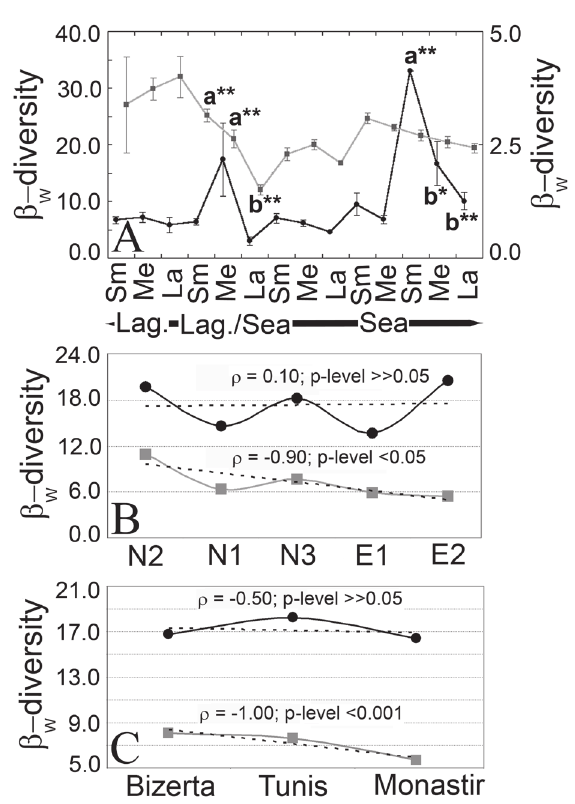
Fig . 5. – Line-plot of turnover of motile- and sessile-associated species at three increasing spatial scales. Sites and localities are primarily arranged according to lagoon-sea environmental gradient and secondarily to according to the north-east geographic gradient. A, beta-diversity at the small-scale level between the total richness of the investigated area and richness of Pinna individuals; means (±Se) are scaled separately for sessile (right) and motile (left) epi- fauna. AnoVA and tukey’s hSd test highlighted differences of means (letters on the top) at a p -level of 0.05 (*) and 0.01% (**). B, beta-diversity at the site level between the total richness and the average richness for each site. c, beta-diversity at the regional level between the total richness and the average richness at each locality. Spearman’s rank correlation ( ρ ) is calculated for habitat gradients (B) and biogeographic gradients (c). Black circles: motile species; grey squares: sessile species (see the text for abbreviations; “Lag.”,